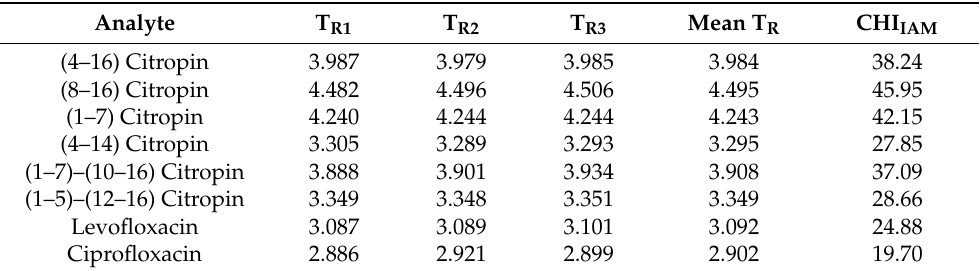
Table 1. The obtained retention times and calculated CHI IAM for the target citropin analogs and fluoroquinolone